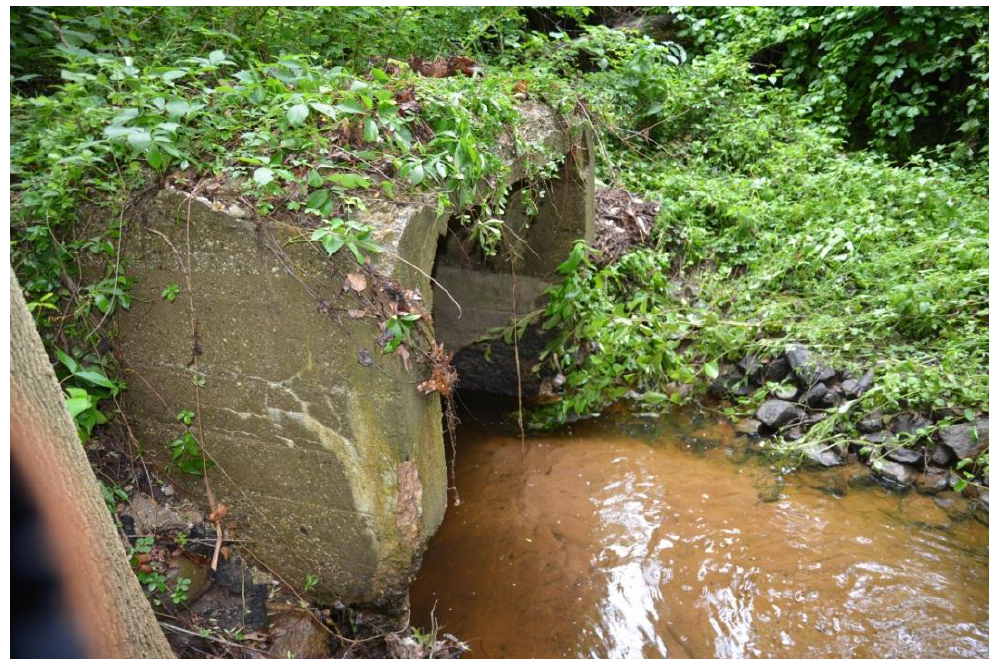
Figure 8. Photograph of inland area #2 (Figures 3 and 4). Photograph taken on 6 June 2015 by Michael Kress and Alan Benimoff, College of Staten Island, The City University of New